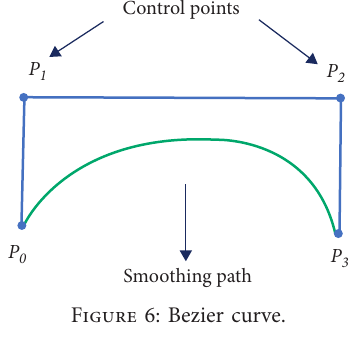
Figure 6: Bezier